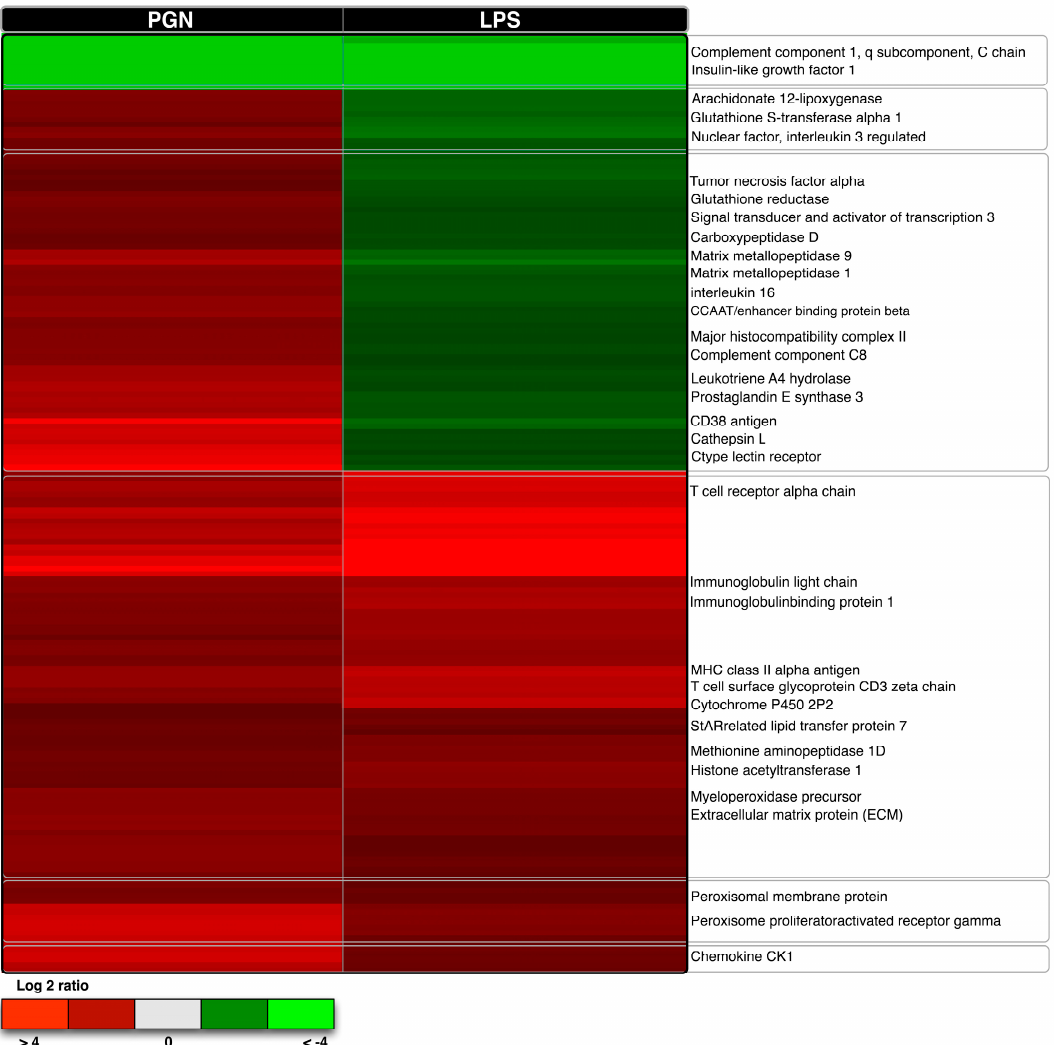
Figure 5. Heat map displaying hierarchical clustering results from microarray expression data common transcripts expressed after the challenge with LPS and PGN. Different genes are represented in different rows, and different experiments in different columns (PGN and LPS). Raw expression values are represented as a colour scale from green for lower expressions to red for higher expressions.